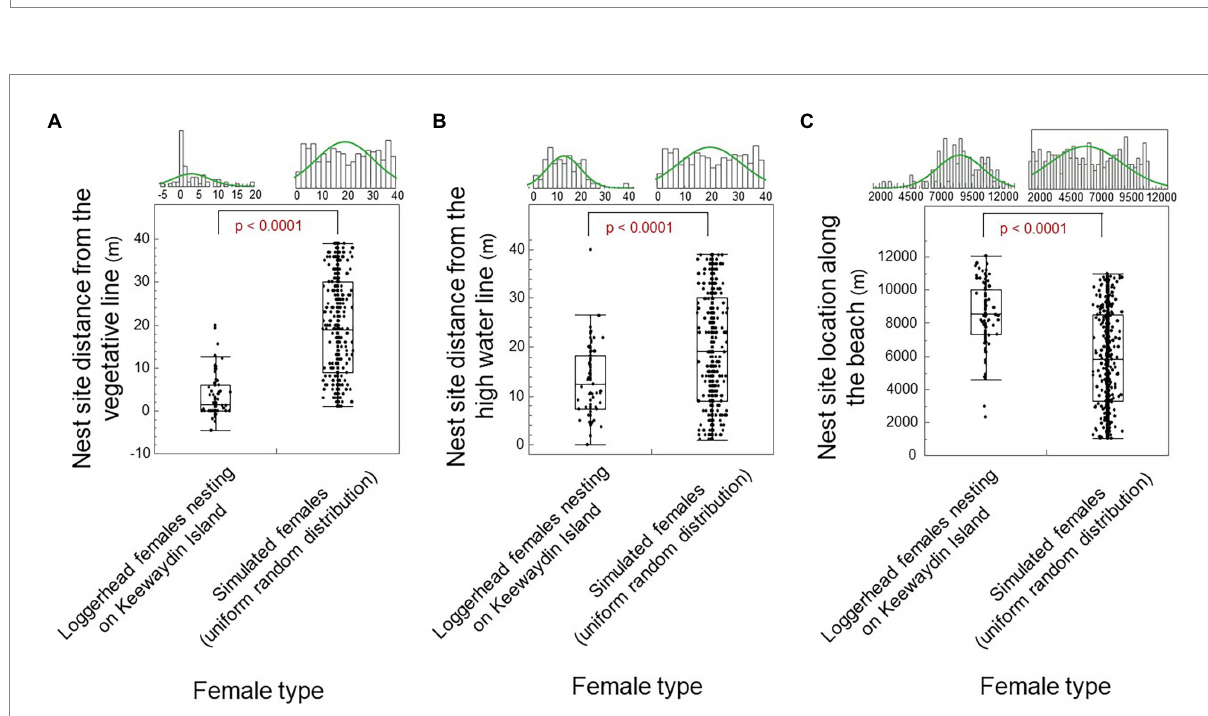
FIGURE 5 Nest site choice by female type (loggerhead females versus simulated females). (A) Nest site distance from the vegetative line by female type. (B) Nest site distance from the high water line by female type. (C) Nest site distance along the beach-length axis by female type. The median shows as a line in the box. The box ends are the 25 and 75th quantiles. Whiskers enclose all data except outliers. Significant differences show as red.